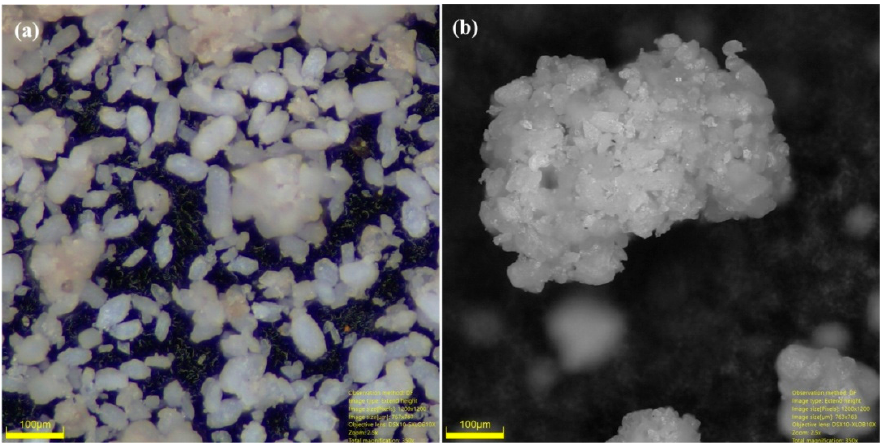
Figure 4. Digital micrographs of (a) irregular morphology and ( b ) cluster of marble waste particulates.